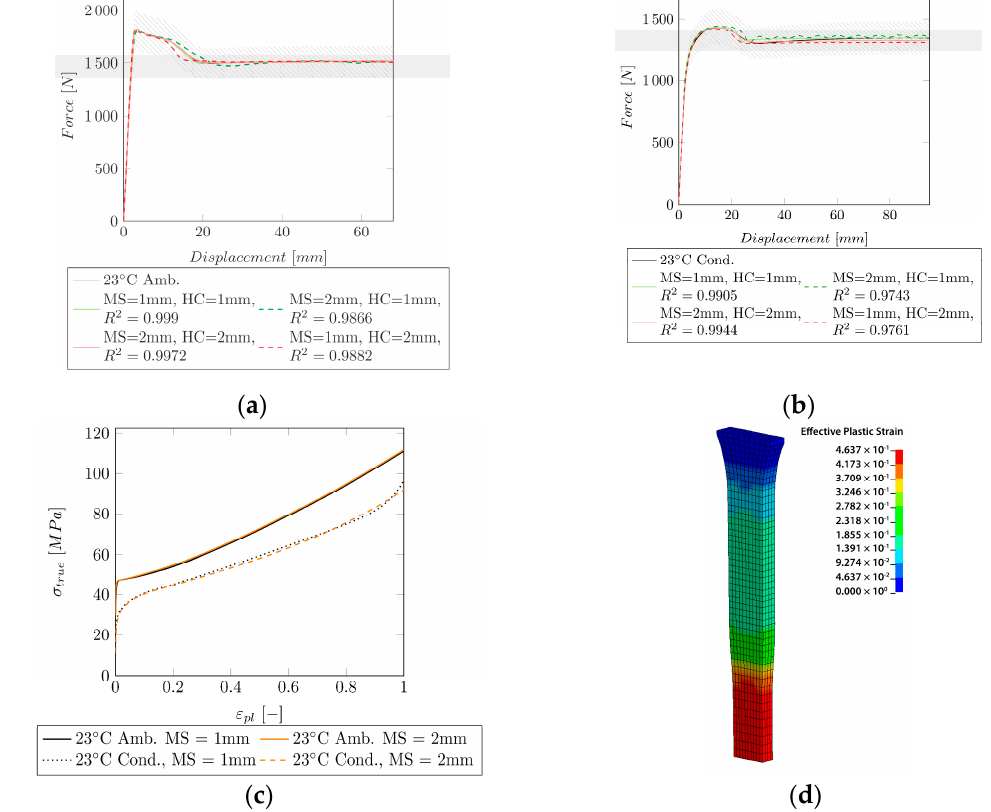
Figure 6. Comparison of the experimental data to the simulation of Group I for two mesh sizes (MS = 1 mm and MS = 2 mm). HC = 1 mm: HC identified with MS = 1 mm, HC = 2 mm: HC identified with MS = 2 mm. The shaded area indicates a ±10% force region around the experimental curve. ( a ) Experimental and simulated force–displacement curves at 23 °C (ambient) including the resulting R 2 . ( b ) Experimental and simulated force–displacement curves at 23 ◦ C (ambient) including the resulting R 2 . ( c ) HCs for 23 ◦ C (ambient/conditioned) for an MS of 1 and 2 mm. ( d ) Neck forming and propagation in the FE model.